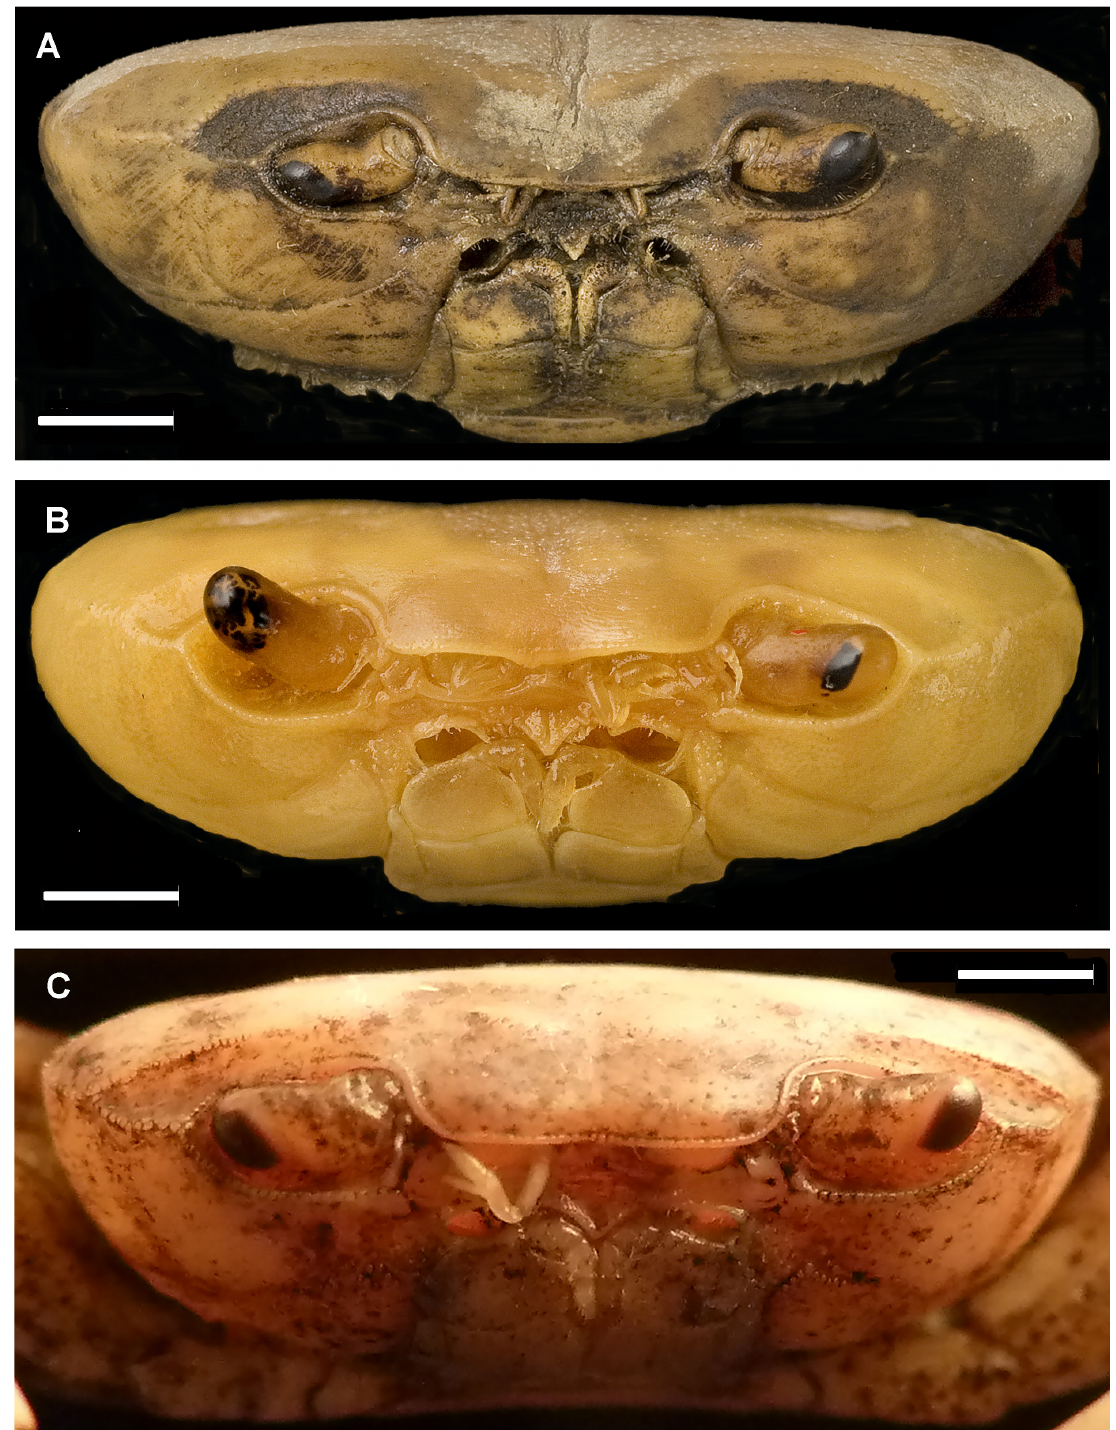
Fig. 4. Frontal view of carapace. A . Potamonautes entebbe sp. nov., holotype, adult ♂, CW 35 mm, from Entebbe, Lake Victoria, southern Uganda (NHMUK 1955.11.8.26). – B . P. busungwe sp. nov., holotype, adult ♂, CW 21.5 mm, from Busungwe Island, Lake Victoria,, southern Uganda (NHMUK 2017.37). – C . P. kantsyore sp. nov., holotype, adult ♂, CW 16.8 mm, from Kantsyore Island in the Kagera River, southern Uganda (NHMUK 2017.29). Scale bars: A = 2.34 mm; B = 3.1 mm; C = 3.3 mm. Photographs A–B by Phillip Crabb,